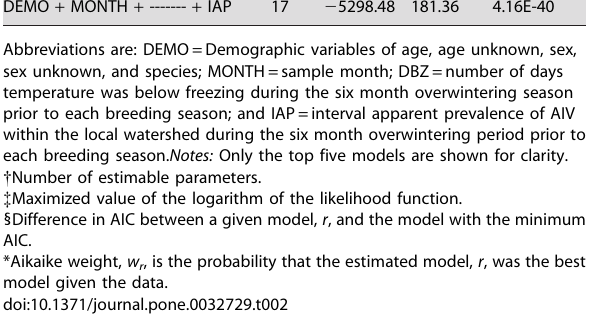
Figure 2 portrays the model-based probability that a randomly sampled bird from each watershed considered in this study would test positive for AIV during the breeding seasons considered in this study. The well-documented pattern of higher infection rates in northern latitudes is made apparent by this figure. Parameter estimates from the global model are shown in Table 3. All values are on the logit scale; however, exponentiation of these estimates provides an odds-ratio interpretation of their effect size. The cumulative number of days below 0 u C during the overwintering